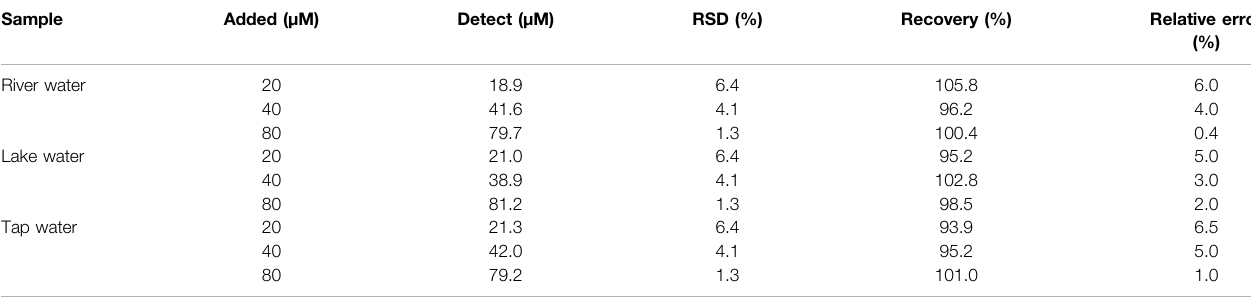
TABLE 1 | Application of probe NpI in determination of Hg 2+ in actual samples.